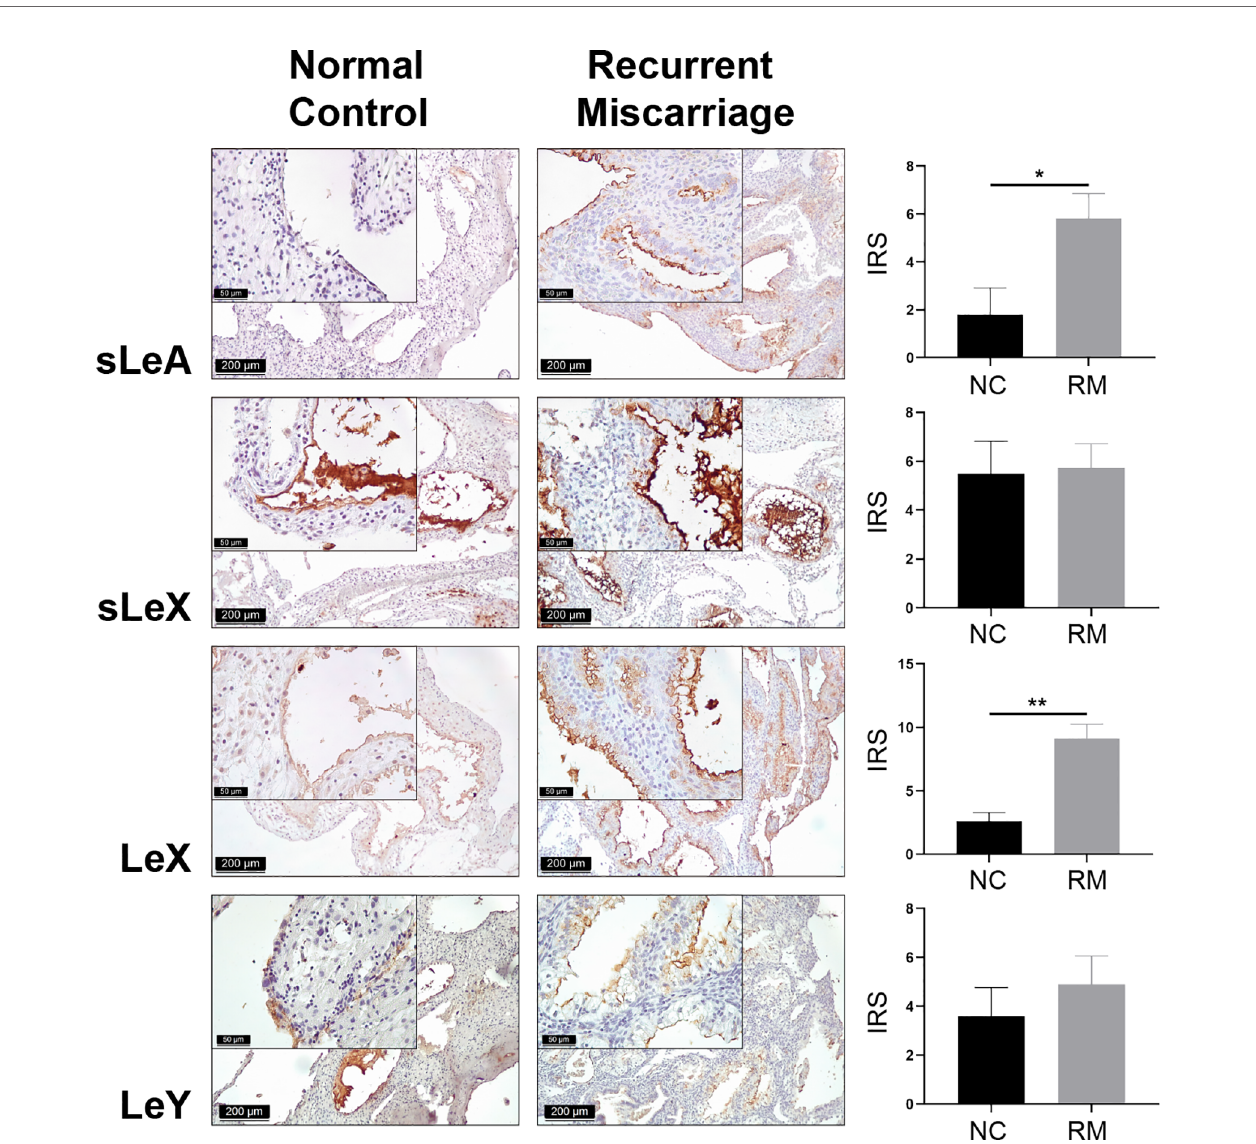
FIGURE 1 | Immunohistochemical staining of Lewis antigens in the decidua of Normal Control group (NC = 10) and Recurrent Miscarriage group (RM = 15) of placenta tissues, demonstrating higher expression of sLeA and LeX in RM than NC. IRS, immunoreactive score. Error bars, S.E.M. * P < 0.05, ** P <